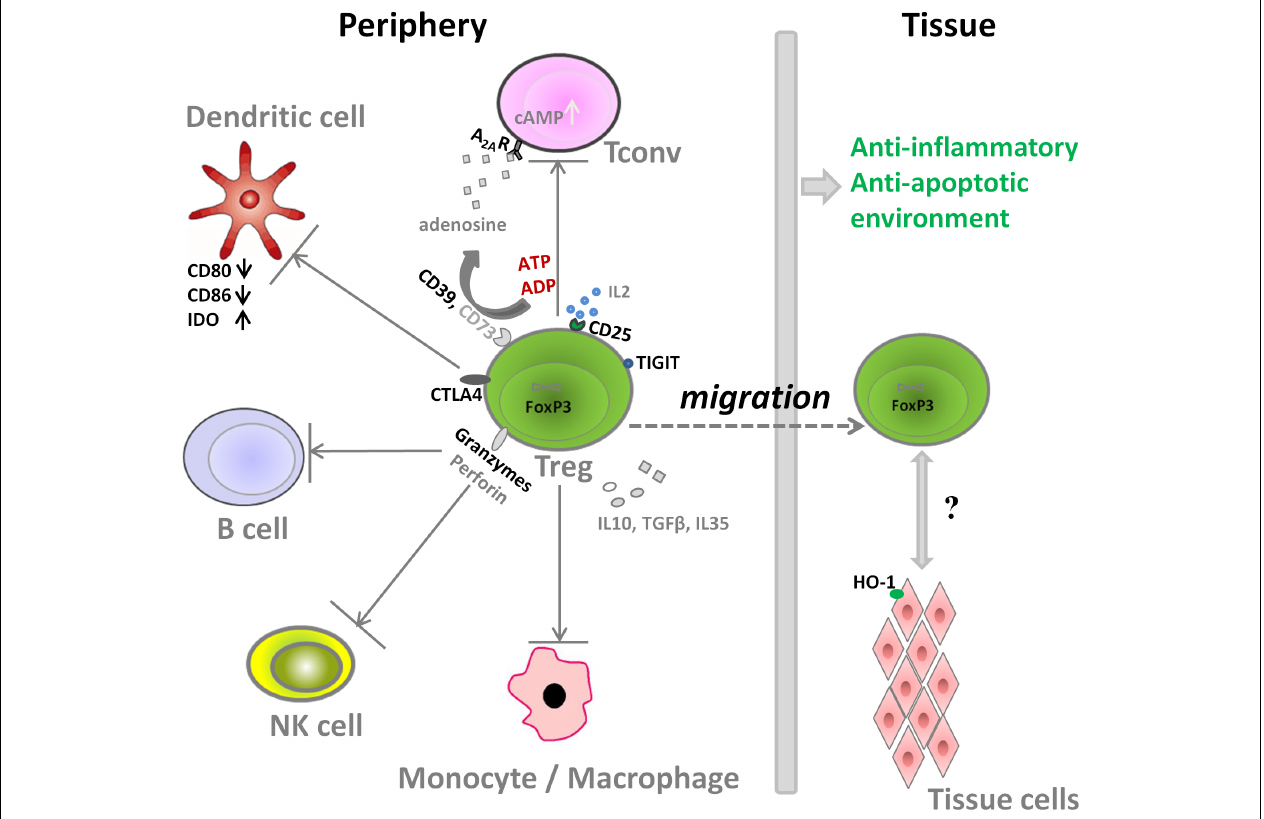
FIGURE 1 | Molecular mechanisms used by Treg for the suppression of immune